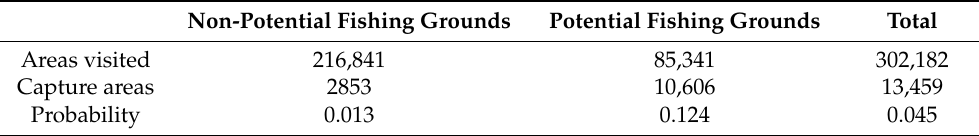
Figure 3. Receiver operating characteristic curve of the evaluation of the neural network model on the test data for the fishery of anchovy ( E. ringens ) in Northern Chile. Table 1. Results of applying the neural network model on the test data (not used for training) from the fishery of anchovy ( E. ringens ) and the oceanographic characteristics of the study area (Northern Chile). Tabulated values correspond to the numbers of cells.